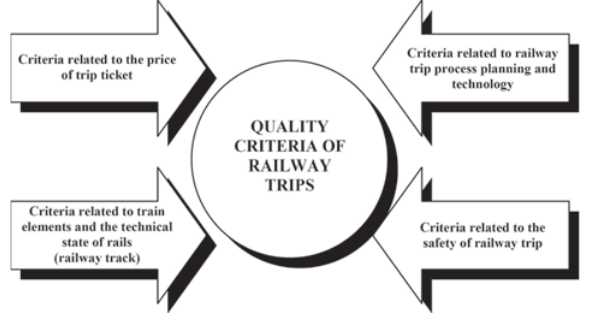
Fig. 2. Th e affi nity diagram of railway trip quality